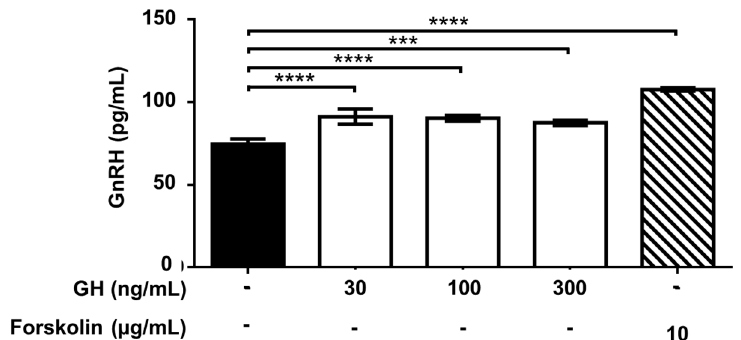
Figure 9. Effect of exposure to growth hormone (GH) on gonadotropin-releasing hormone (GnRH) release by GT1-7 cells. Cells were incubated for 90 min with different concentrations of GH. Data are expressed as mean ± SD, n = 4. One experiment representative of three separate experiments is shown. *** p < 0.001; **** p < 0.0001 vs. Control (black bar) (One-way ANOVA followed by the Dunnett post-hoc test).